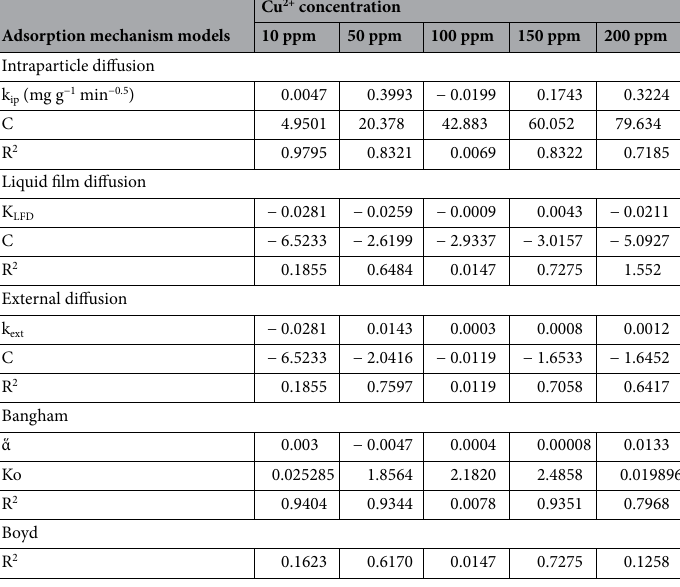
Table 8. Adsorption Mechanism models for Sorption of Cu 2+ onto